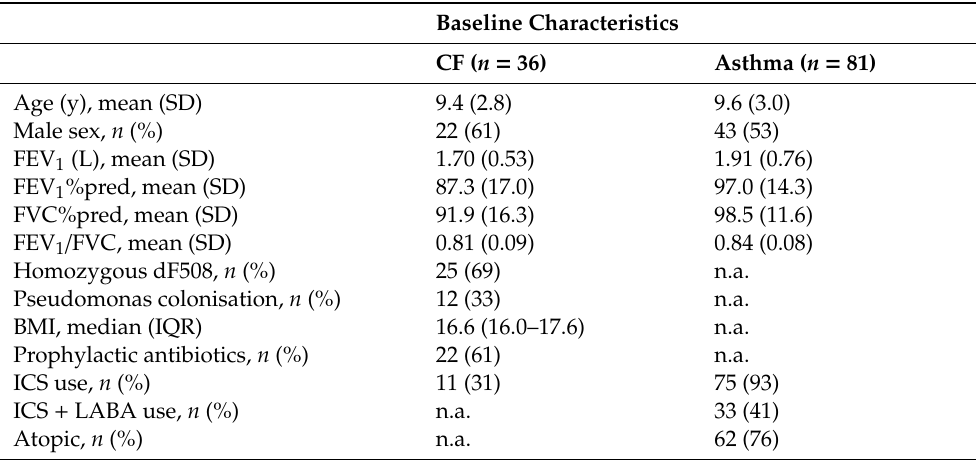
Table 1. Patient